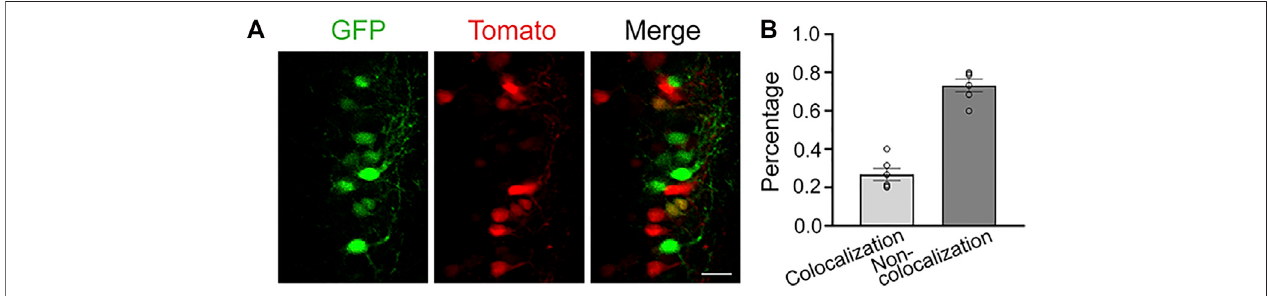
FIGURE4| DualIUE12-hapartleadstocolocalizationbetweenthetwoelectroporatedcellpopulations. (A) :ImagesofelectroporatedneuronsintheSSCfollowing a dual IUE 12-h apart (green: pCAG-GFP; red: pCAG-tdTomato). (B) : Quanti fi cation of the GFP and RFP colocalization and non-colocalization. Bar: 25 μ m, 2 slices per mouse, N (cid:2) 3